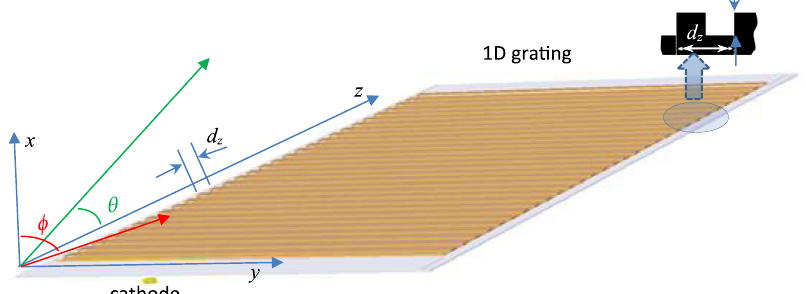
FIG. 1. (a) Schematic of a one-dimensional (1D) metal grating and coherent Smith-Purcell radiation generation via scattering of the surface charges and dispersion. (b) 3D numerical drawing of the 1D grating by MAGIC 3D software package used for the studies; the inset shows the grating